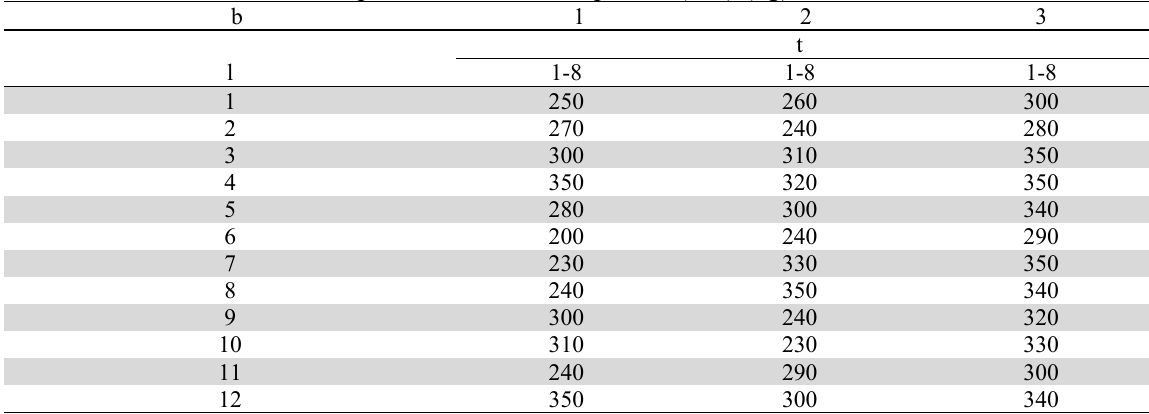
Retailers' demand for different products at different periods(D bt l ) (kg)